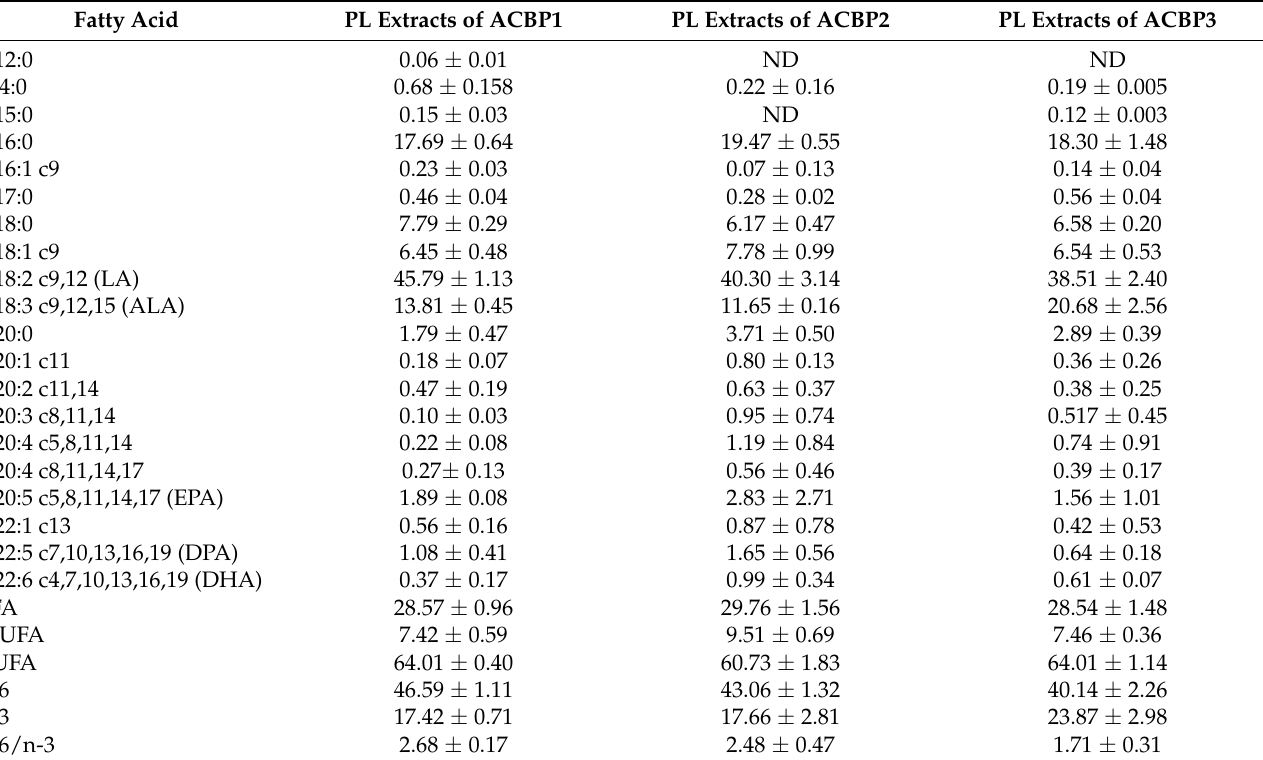
Table 3. The fatty acid profile of the PL extracts for each ACBP apple pomace, expressed for each FA as the mean value of its % percentage in the total fatty acids of each sample assessed (mean ± standard deviation (SD), n = 3). Fatty Acid PL Extracts of ACBP1 PL Extracts of ACBP2 PL Extracts of